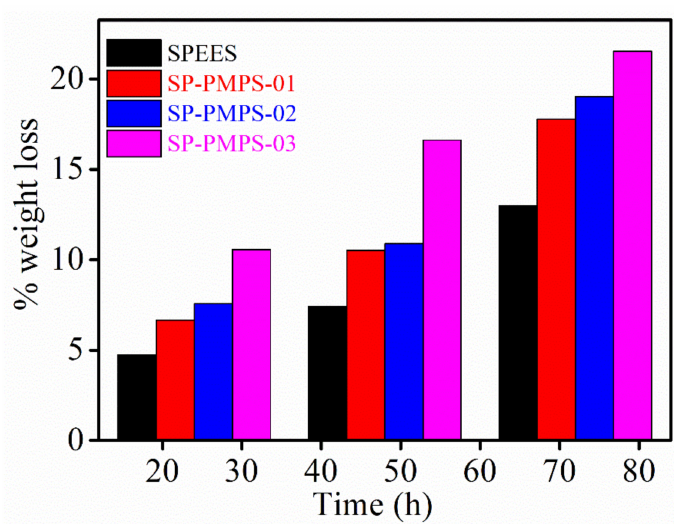
Figure 7. Oxidative stability test for SP-PMPS based